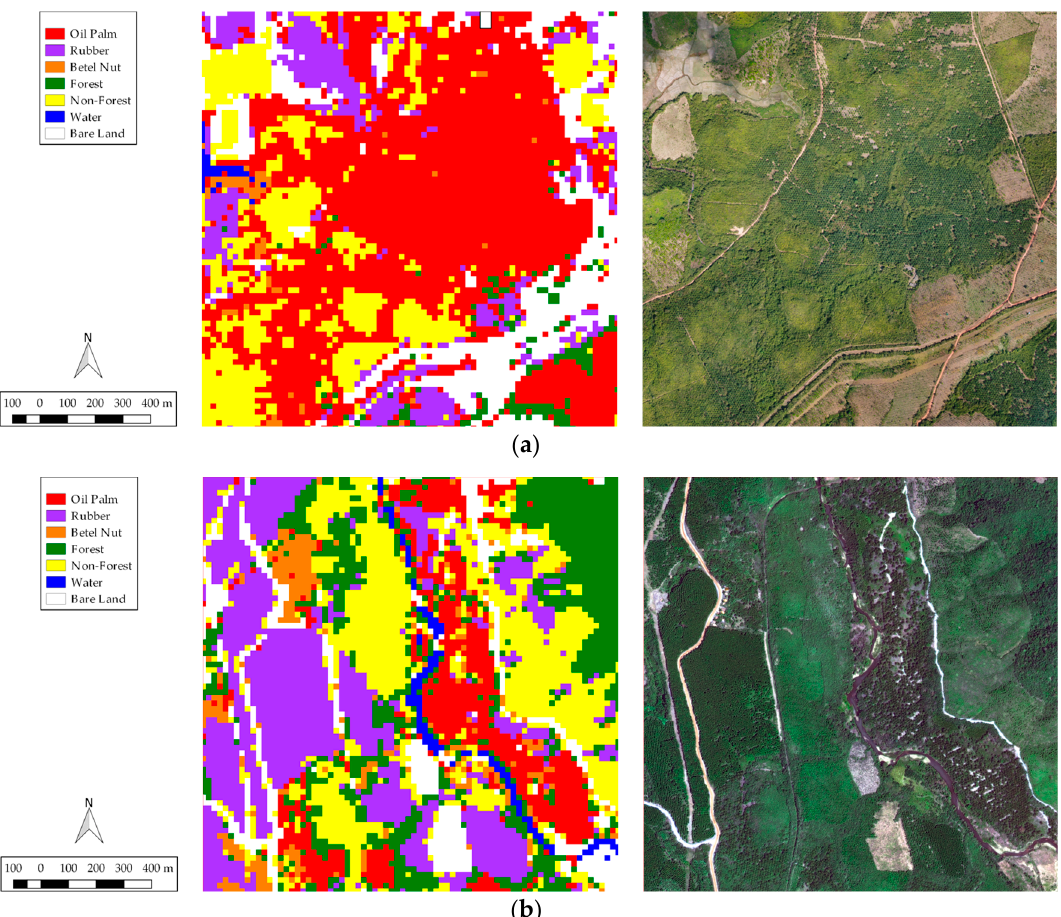
Figure 6. S2 classification results for parts of ( a ) Area A in February 2017 with the UAV image on the right; ( b ) Area B in March 2018 with the WV3 image on the right. Table 6. Overall classification accuracy using Sentinel-2 data at a 20 m spatial resolution with 1000 Random Forest classification runs.